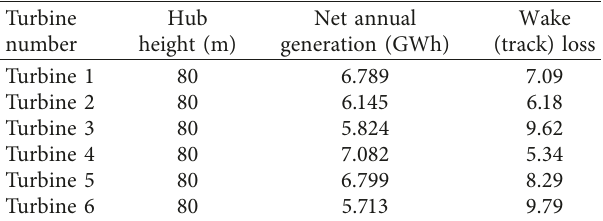
Table 4: Annual generation and loss values of 6 V80 wind